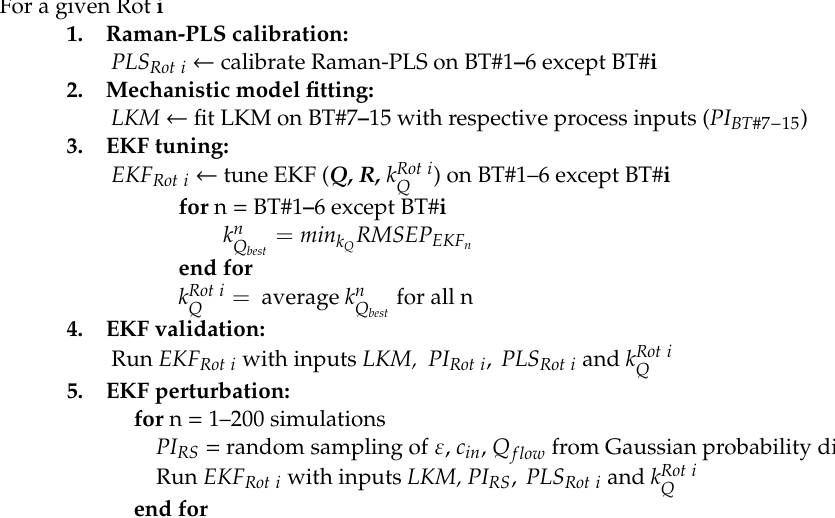
Table 2. Modeling procedure including the Raman-PLS (partial least squares) calibration, mechanistic model fitting, as well as the tuning, validation and perturbation of the extended Kalman filtering (EKF). For a given Rot